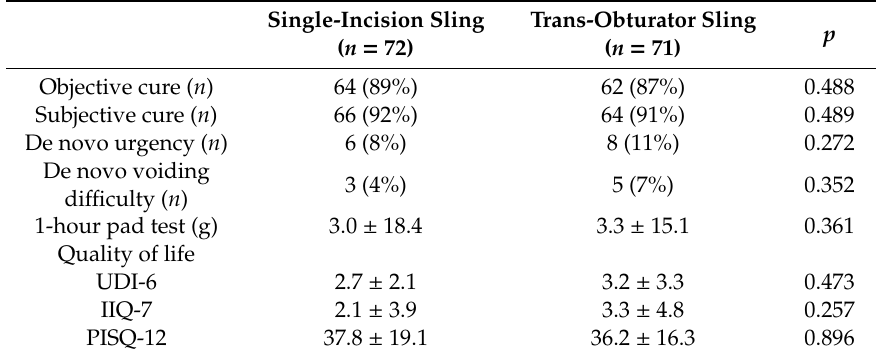
Table 2. Outcomes of the overweight women (BMI: 25–29.9 kg / m 2 ) after receiving a single-incision sling or trans-obturator sling.